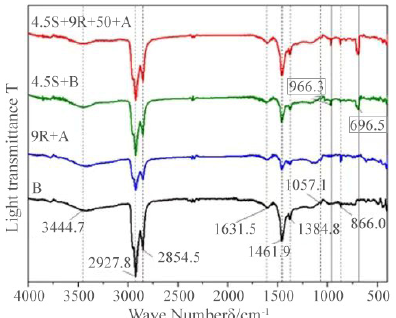
Figure 8. Infrared spectra of different types of asphalt.